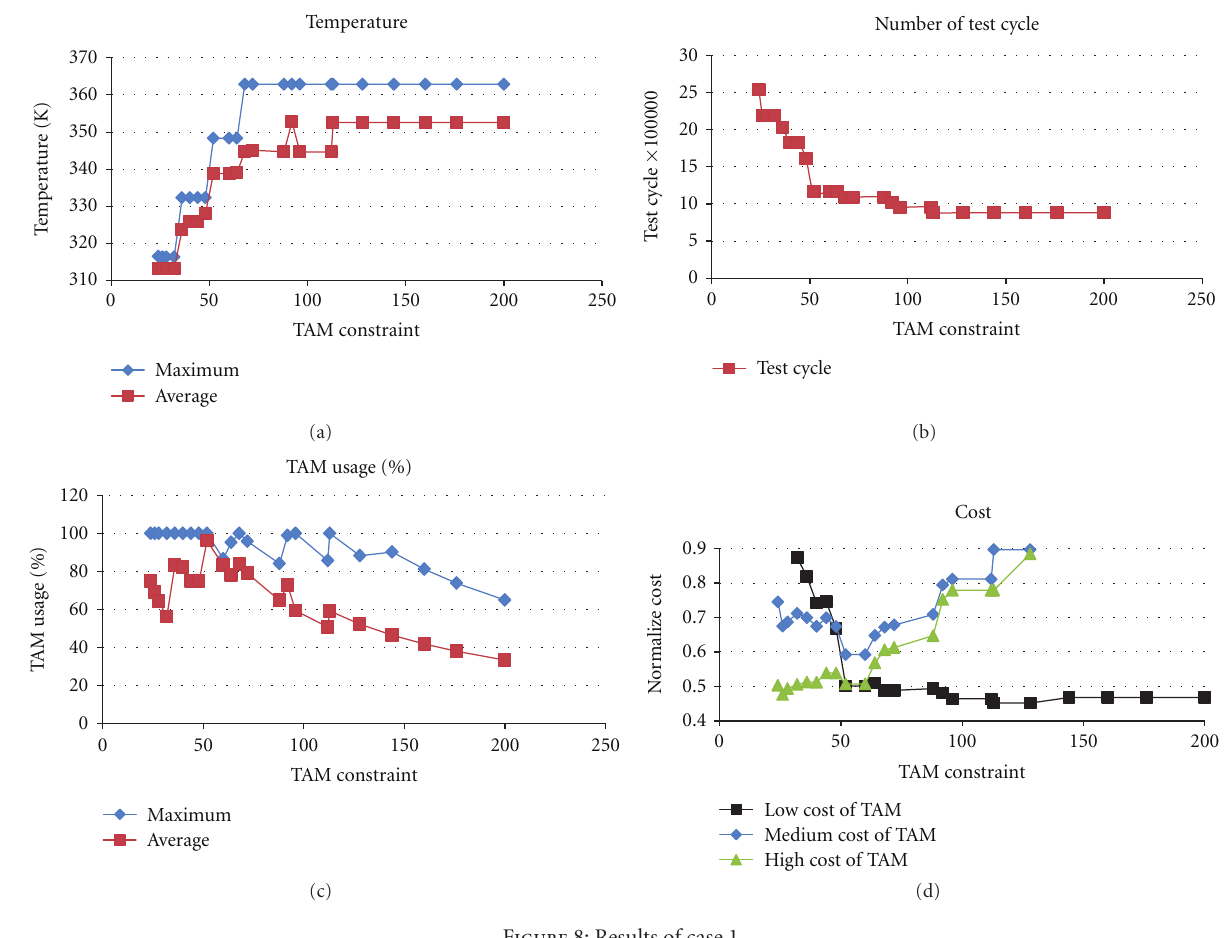
Figure 8: Results of case